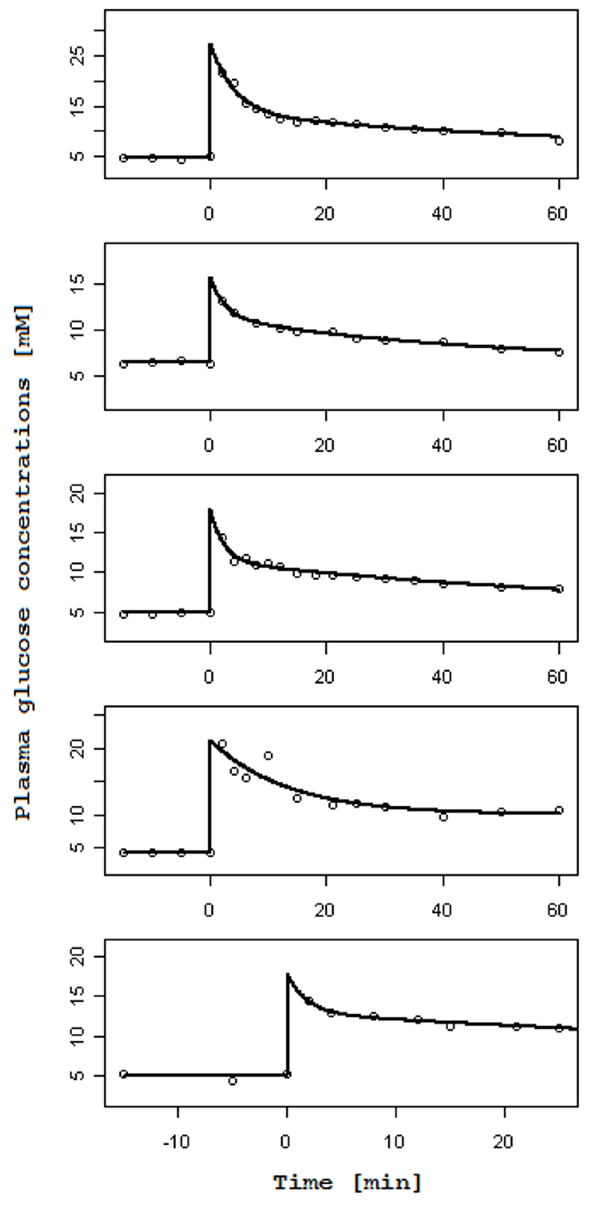
Figure 2. Observed and predicted Plasma Glucose Concentra- tions. Observed and Predicted Plasma Glucose concentrations (mM) over Time (min) as derived from the two-compartment model for the five analyzed